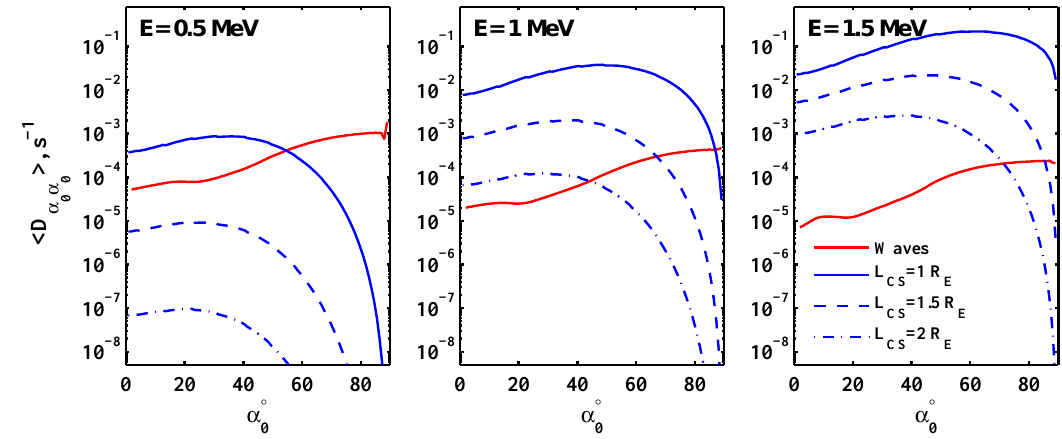
Fig. 2. Comparison of the pitch-angle diffusion coefficients for resonant wave–particle interactions and for nonadiabatic